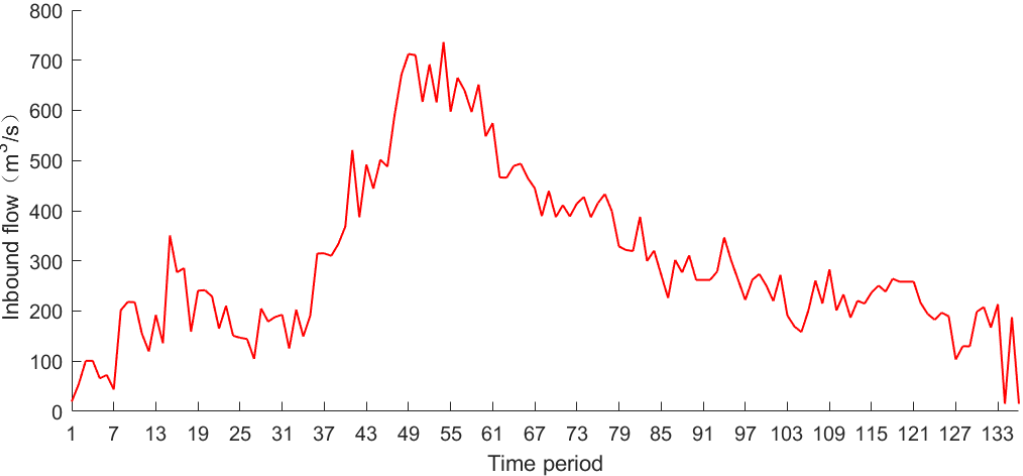
Figure 7. The inflow process line of the first flood.